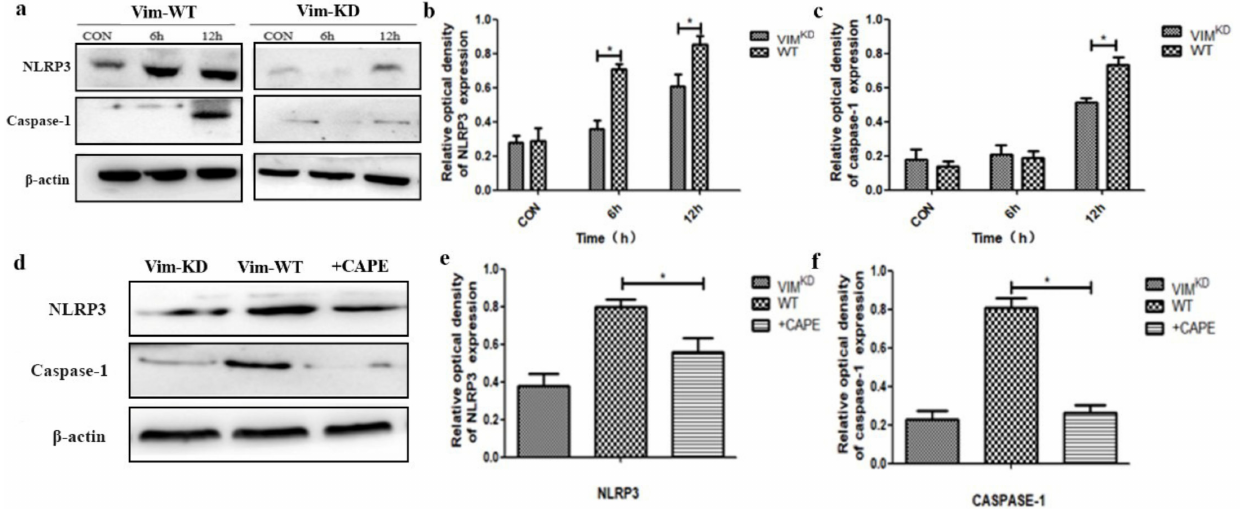
Figure 5. Vimentin and NF- κ B signaling pathway are essential for the EV-71-induced inflammasome activation. ( a ) The expressions of NLRP3 and caspase-1 protein detected by Western blotting between VIM +/+ cells and VIM − / − cells. ( b , c ) Optical density analysis of NLRP3 and Caspase-1 by Western blotting. ( d ) Western blot detected the NLRP3 and caspase-1 protein expression among VIM +/+ cells, VIM − / − cells and CAPE cells. ( e , f ) NLRP3 or Caspase-1 and β -actin ratio analyzed by gray analysis of Western immunoblotting. * p <